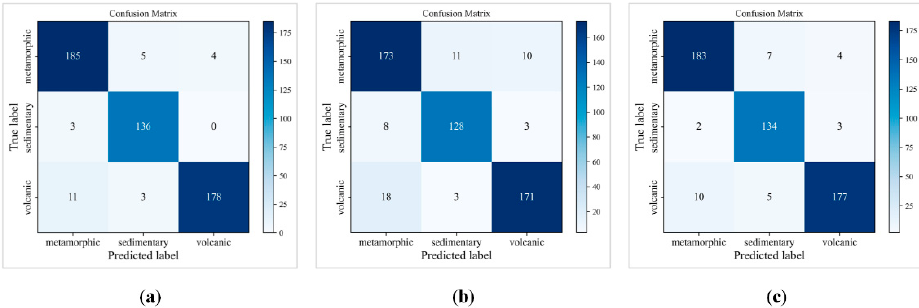
Figure 18. Confusion matrixes: ( a ) RMSprop optimizer; ( b ) SGD optimizer; ( c ) Adam Table 6. Detailed classification results for all rock types.